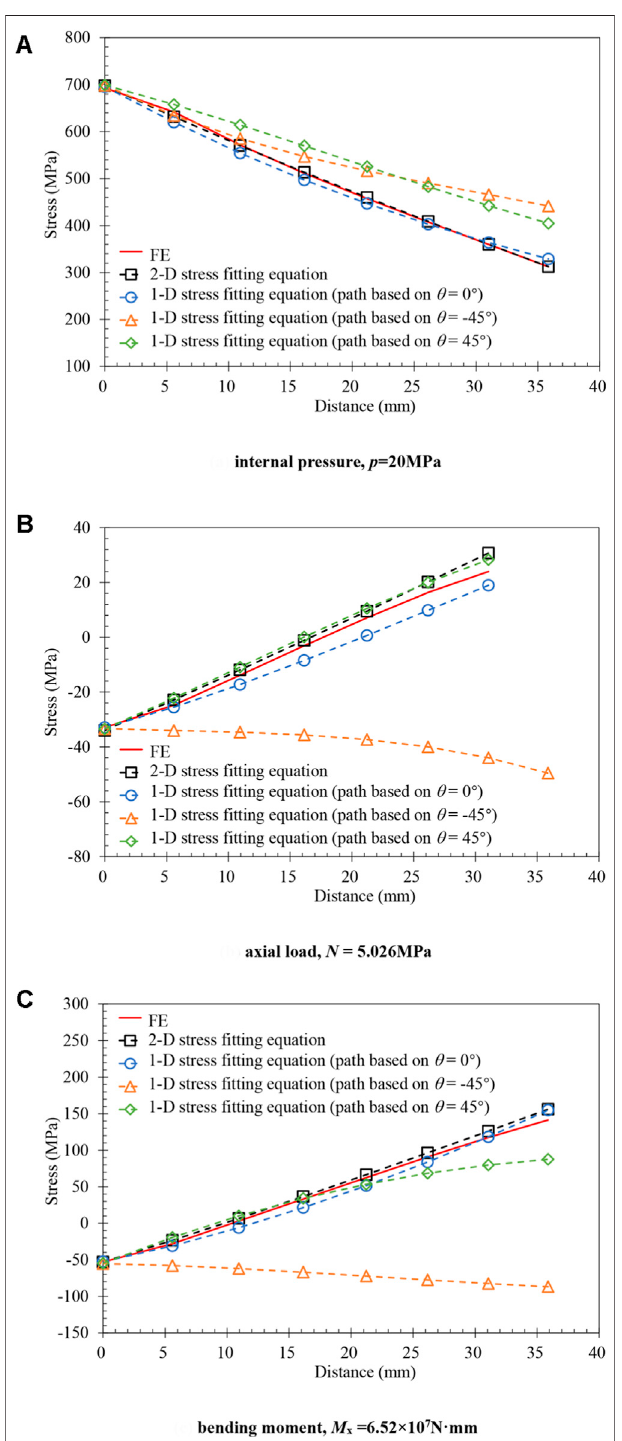
FIGURE 9 | Comparison of stress fi tting results ( c (cid:1) 0.185, κ (cid:1) 0.0705, δ (cid:1) 1, φ (cid:1) 1, and R (cid:1) 20 mm).